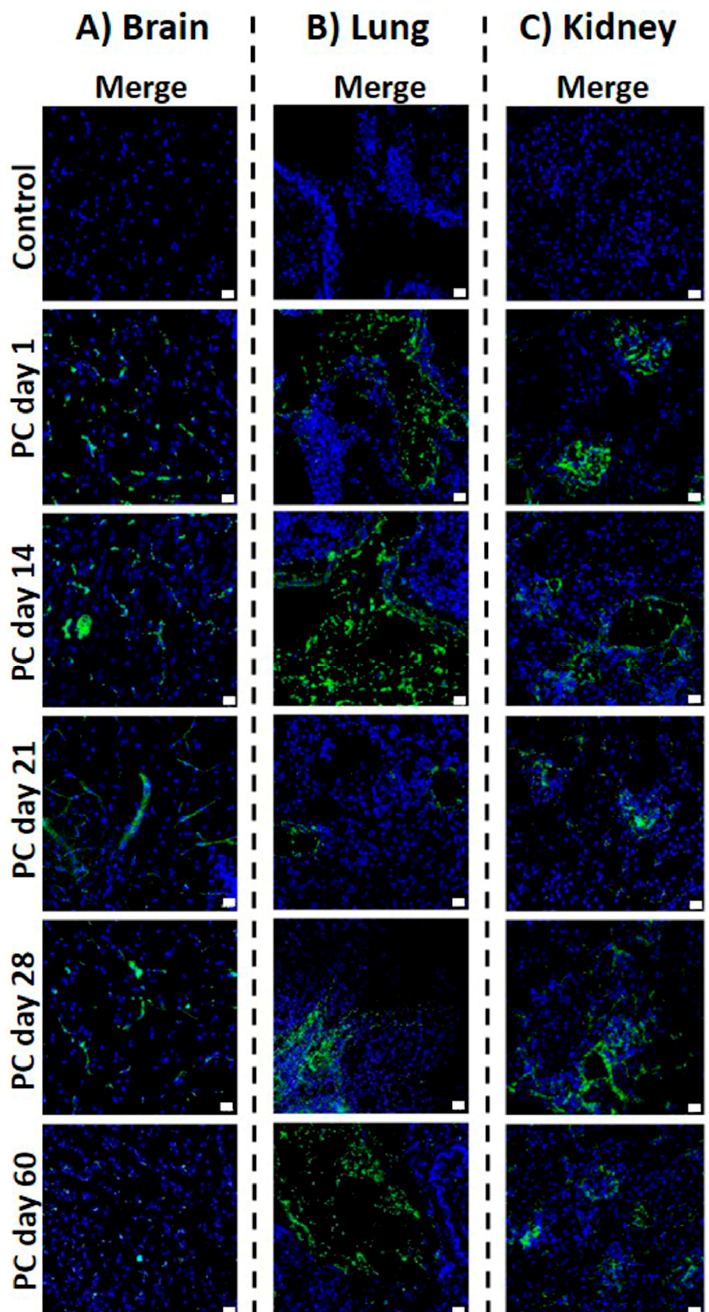
Figure 5. Immunofluorescence characterization of brain, lung, and kidney tissues. ( A ) The deposition of ICs (green channel) in the brain was evident since day one in the mice treated with the cell wall extract, with the MFI peaking on day 14. Thereafter, the MFI progressively decreased, although the deposition of ICs allowed visualization of the vascular trajectories even 21 days. On day 60, the MFI was minimal, and the control group did not show any fluorescence; ( B ) immunofluorescence characterization of lung tissue. The deposition of ICs (green channel) was observed since day one, again being day 14, the time point with the greatest MFI. The fluorescence intensity decreased gradually after day 14, though it was still visible on day 60. The control group did not show any fluorescence. ( C ) ICs (green channel) were deposited in the kidney glomeruli from day 1, peaked on day 14, and slightly decreased on days 28 and 60. Cell nuclei are evident in the blue channel. Scale bar: 10 µ